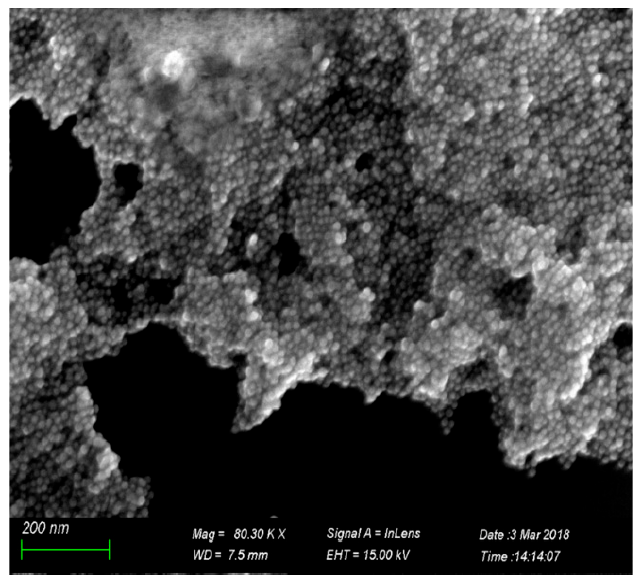
Figure 4. SEM image of the aggregated stage of the AuNPs.